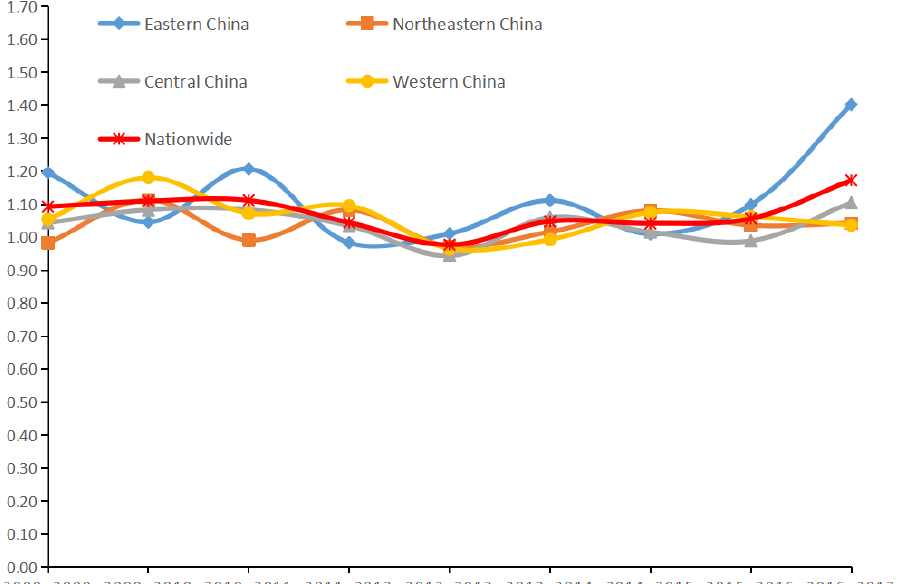
Figure 4. Trends in the annual average GML index in the four regions from 2008 to 2017. The change trend of the annual average GML index in the four regions from 2008 to 2017 was similar, and all of them were in oscillating and fluctuating state. The trend of change in the central region was basically consistent with the national trend, with a slow rise during 2008–2011, and began to decline after 2011, reaching the lowest in 2013 with an average value of 0.945, and then a fluctuating upward trend, reaching the highest in 2017 with an average value of 1.105, and generally speaking, the efficiency of investment in environmental pollution control has improved. The western and northeastern regions fluctuate in a basically consistent state, and the overall was in an upward trend. The eastern region has the largest fluctuation. During the period of 2008–2015, it showed repeated fluctuations of falling, then rising, and then falling, and after 2015, it gradually showed an upward trend and reached the highest in 2017, with a mean value of 1.402, and the overall efficiency has improved. In order to clarify the reasons for the changes in the efficiency of environmental pollution control investment in each region, the annual average GML index of the four regions is also decomposed, and the results are shown in Table 6. Overall, the EC index and TC index of the four regions were both higher than 1 during the decade, which indicates that both the efficiency and technology of environmental China pollution control investment have improved during this period. The TC indexes of all four regions were greater than the EC indexes, which indicates that the improvement in the efficiency of environmental pollution control investment in each region was mainly due to the progress in technology. In terms of the ten-year national average, the EC index was greater than 1 in 2009, 2011, 2012, 2013, 2014, 2016, and 2017, indicating that the improvement in technical efficiency during the period was conducive Table 6. Decomposition results of the average GML index by year for the four regions. to the improvement in the efficiency of environmental pollution control investment. In contrast, the TC index was higher than 1 in all years except 2013 when it was less than 1, indicating that the improvement of technology contributes significantly to the improvement of investment efficiency in environmental pollution control in the rest of the period except 2013. The TC index was higher than 1 for the three regions of East, Central, and West except for three years in 2011, 2012, and 2013, which indicates that for these three regions, the improvement in the efficiency of investment in environmental pollution control was more obvious due to the improvement of